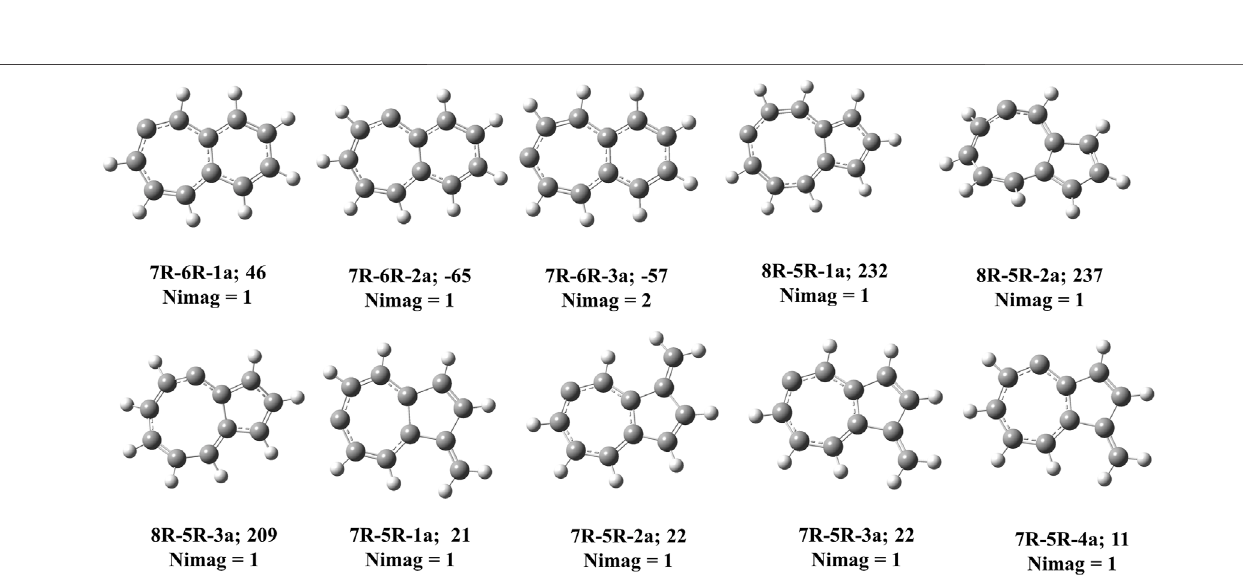
Frontiers in Physics |